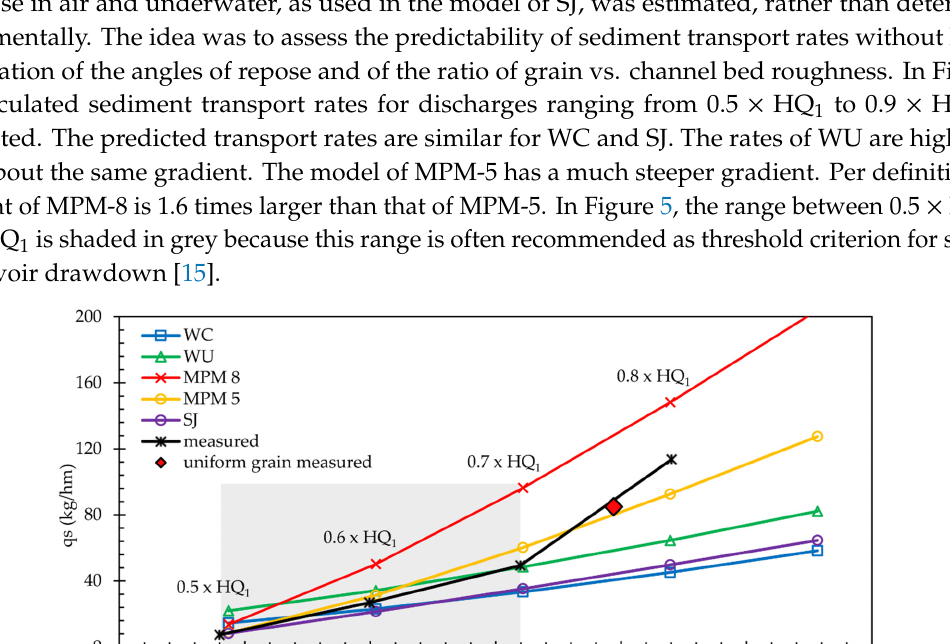
Figure 5. Sediment transport rates flow rates ranging from 0.5 × HQ 1 –0.9 × HQ 1 : calculated sediment transport rates according to models of MPM, SJ, WC and WU. Measured transport rates of present study (black line) and of a previous study under similar conditions (red diamond)